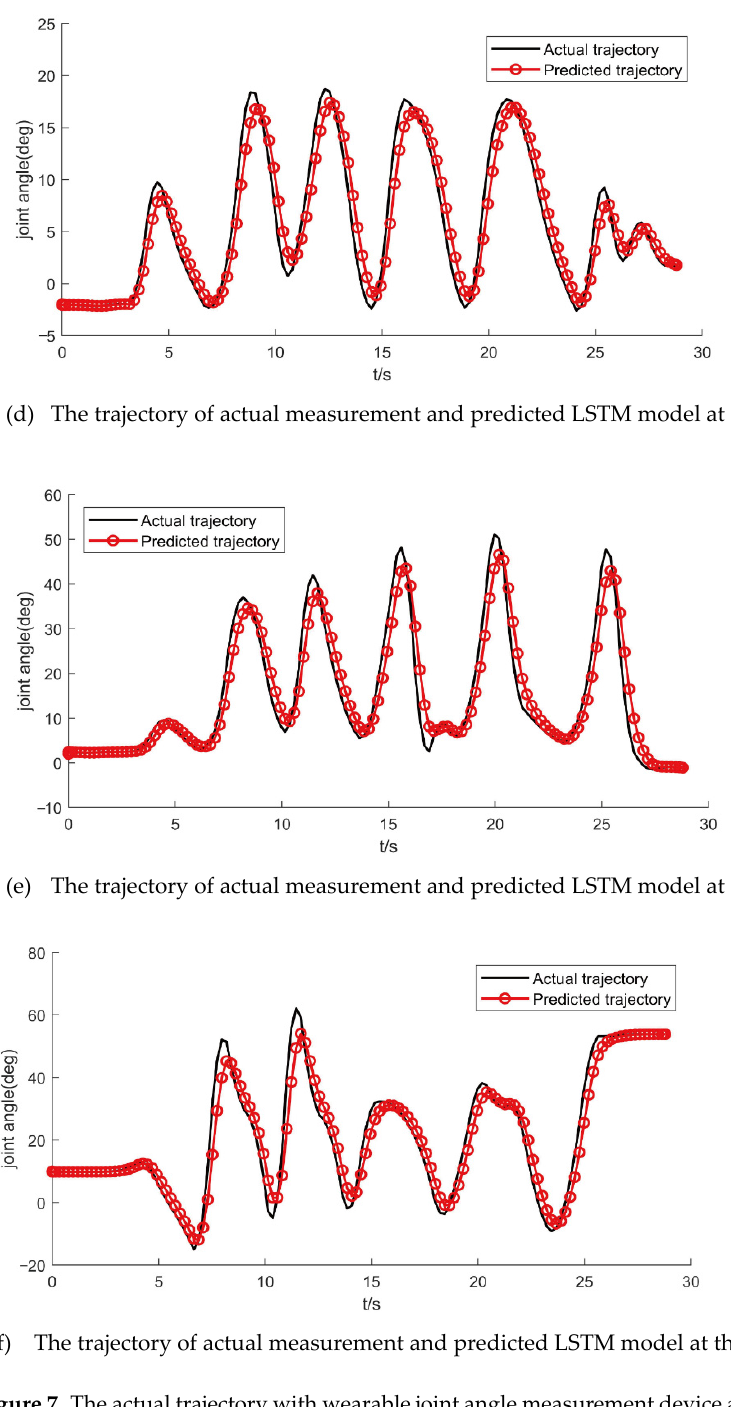
Table 2. The prediction result of actual trajectory with wearable joint angle measurement device.